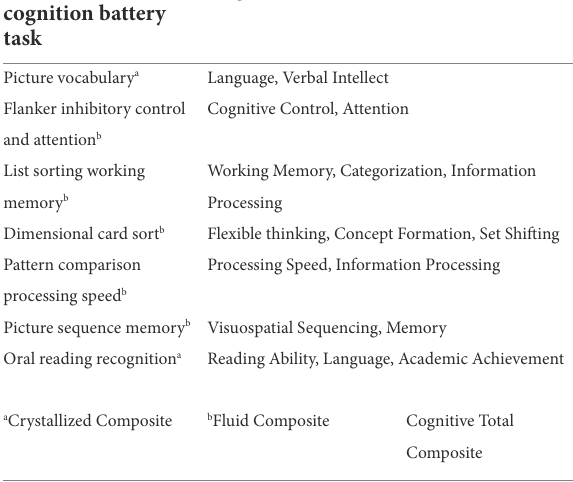
TABLE 1 NIH toolbox cognition battery (Luciana et al.,